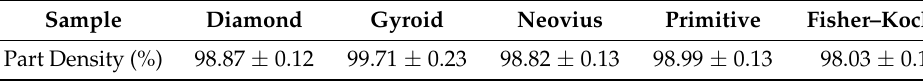
Table 2. The part densities of the sandblasted TPMS samples.